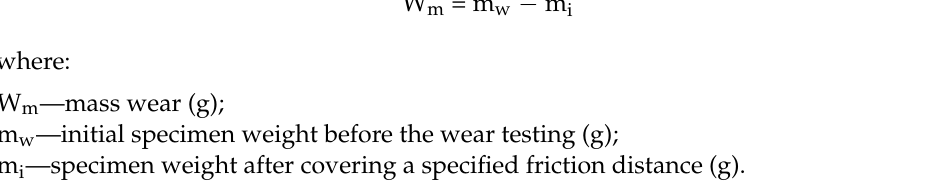
Table 5. Soil mass characteristics.